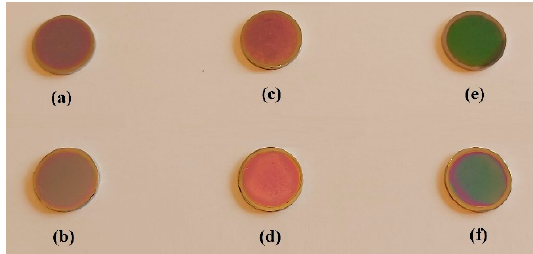
Figure 1. Samples of Co-Cr alloy sintered using DMLS technology and coated with thin films: ( a , b ) samples S1 and S2 coated with Ta 2 O 5 ; ( c , d ) samples S3 and S4 coated with 75% Ta 2 O 5 ; 25% ZnO; ( e , f ) samples S5 and S6 coated with 50% Ta 2 O 5 ; 50% ZnO.